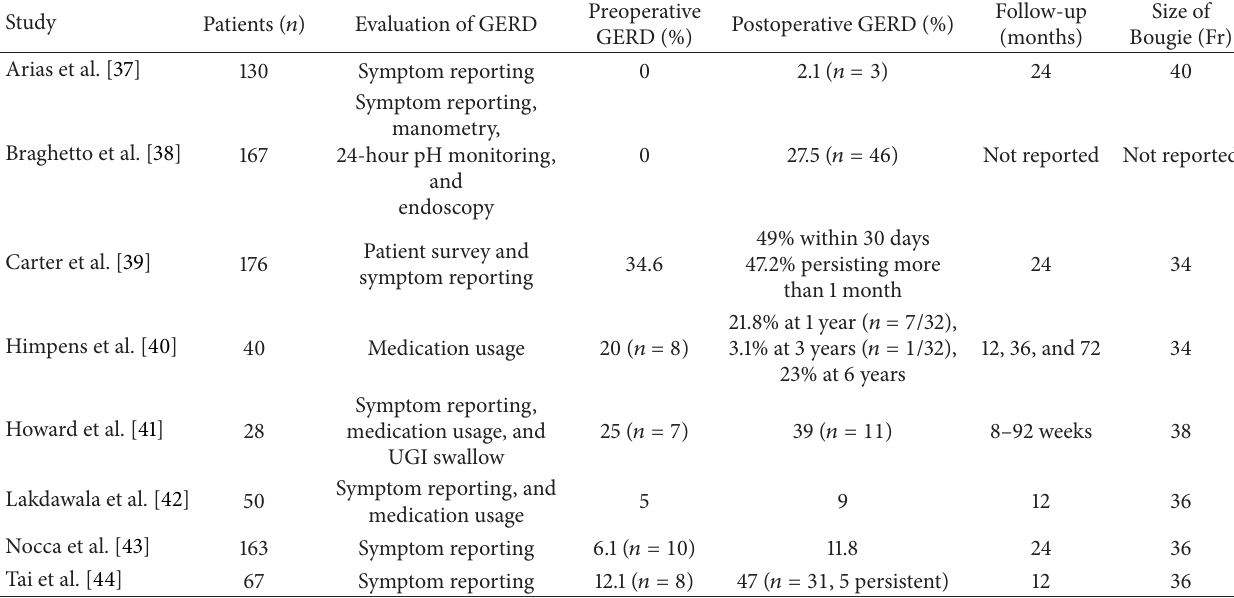
Table 1: Summary of studies showing increased GERD after sleeve gastrectomy.